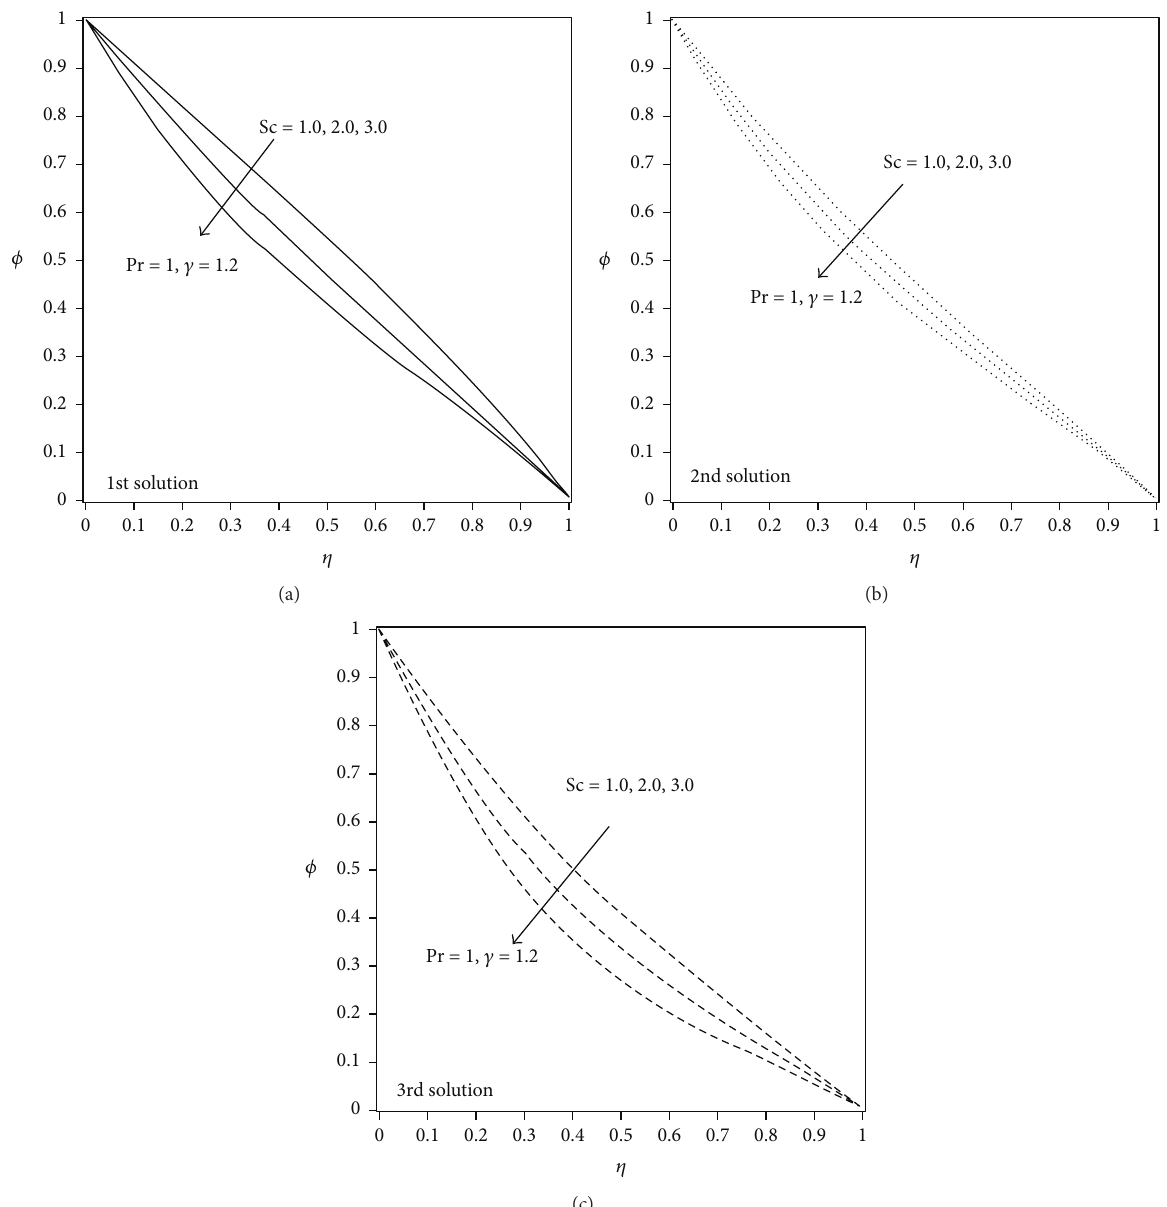
Figure 6: Effect of Smith number Sc on concentration profile 𝜙(𝜂) for 𝜆 =